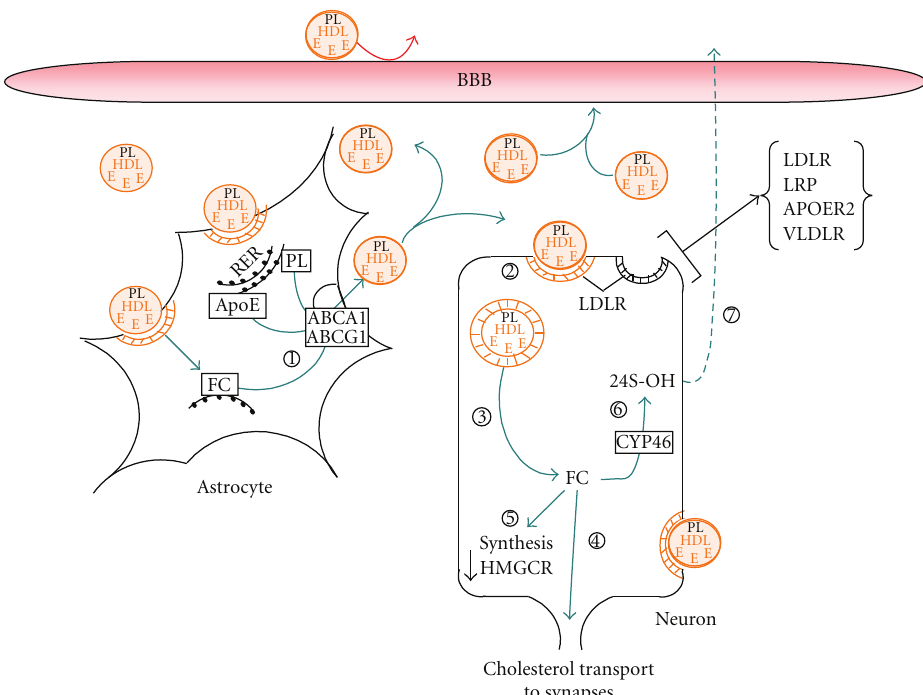
Figure 2: Cholesterol transport in the CNS. APOE is synthesized by astrocytes and assembles free cholesterol (FC) and phospholipids (PLs) to form HDL-like particles. (1) Lipidation of these lipoparticles is facilitated via the mobilization and distribution of lipids to the cell surface by ABCA1/G1. Once secreted in the extracellular space, these HDL-like particles are directed either toward the circulation through the BBB and/or to neurons requiring lipids. (2) These APOE-HDL-like particles are recognized and endocytosed by members of the cell surface LDLR family (LDLR, LRP, APOER2, VLDLR), and (3) the FC is released within neurons and can be used for neurite elongation and/or synaptogenesis (4). As a result of lipid internalization, the endogenous synthesis of cholesterol within neurons (via the HMGCR pathway) is repressed (5). Excess cholesterol will be removed from neurons through its conversion into 24S-hydroxycholesterol (24S-OH) which is mediated by cholesterol 24S-hydroxylase (CYP46) (6). This sterol can now freely cross lipophilic membranes of the BBB and exit the brain for elimination (7). APOE or E: apolipoprotein E; BBB: blood-brain barrier; RER: rough endoplasmic reticulum; HMGCR: 3-hydroxy-3- methylglutaryl coenzyme A reductase; HDL: high-density lipoprotein; LDLR: low-density lipoprotein receptor.